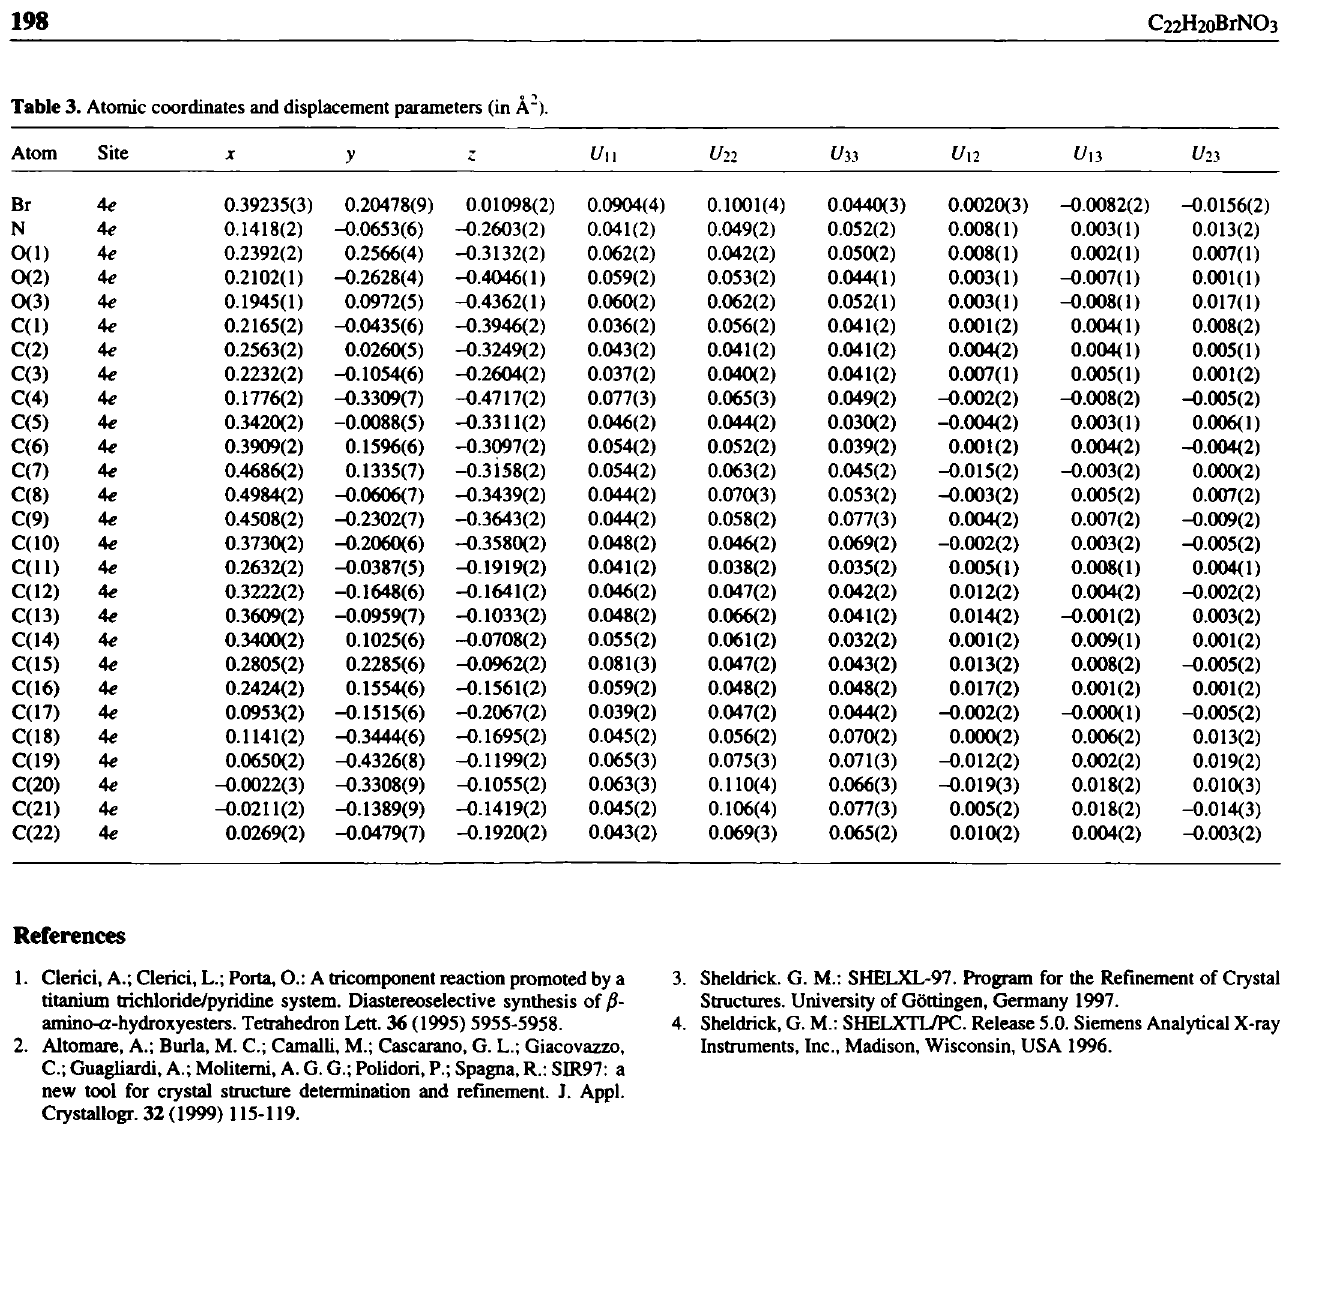
Table 3. Atomic coordinates and displacement parameters (in